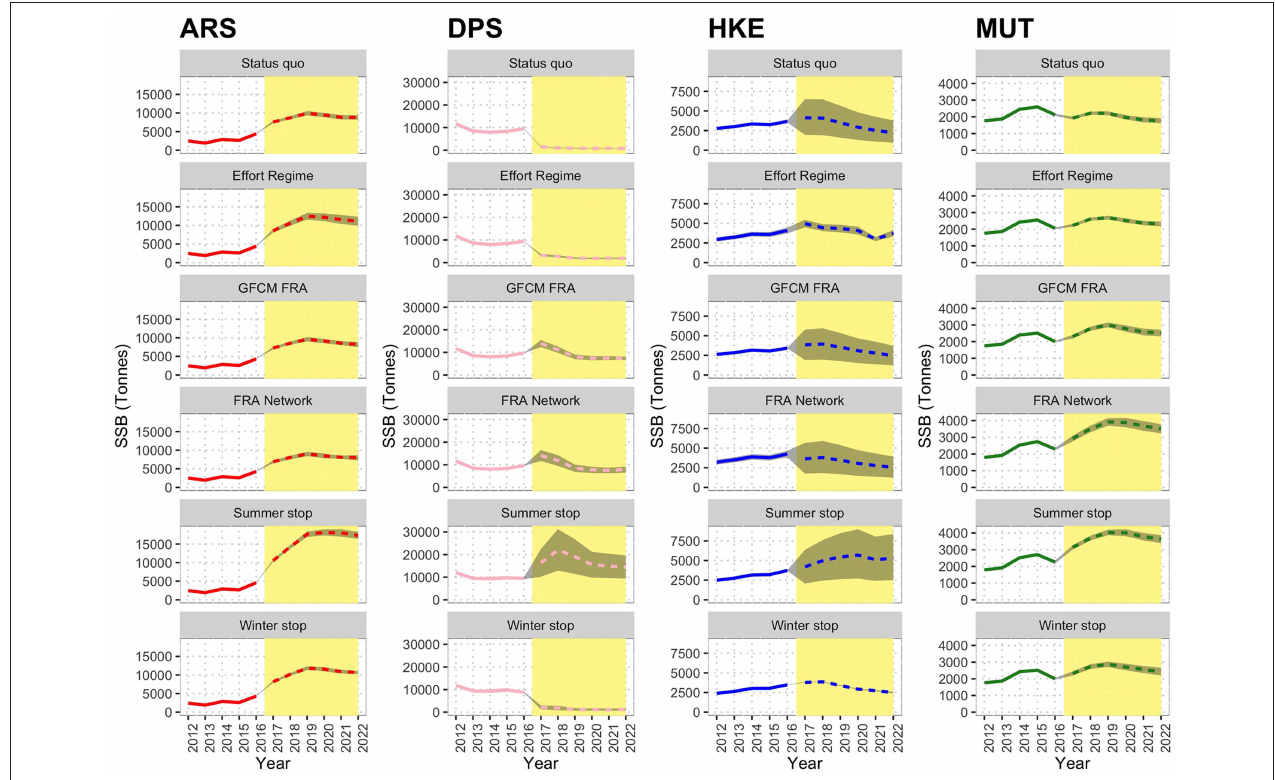
FIGURE 10 | Reconstructed and predicted trends of Spawning Stock Biomass (SSB) by scenario for the different species. The white background identifies the observed time series (years 2012–2016), while the yellow background corresponds to prediction (years 2017–2022). In the predictions, the dashed line marks the mean trend over 100 simulations, while the gray area corresponds to the standard confidence